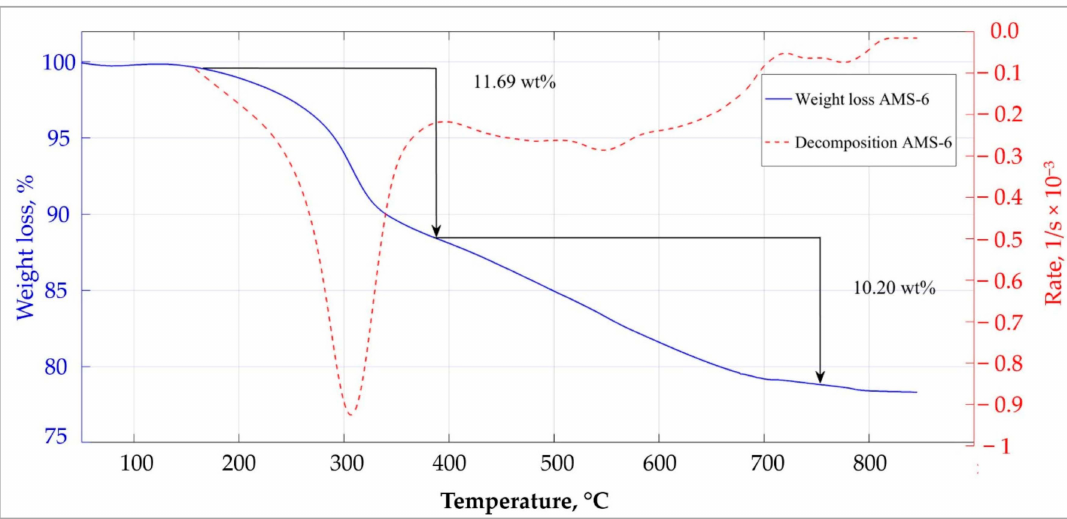
Figure A19. Thermogravimetric analysis of the unloaded AMS-6 nanoparticles sample. The thick blue line corresponds to the weight loss versus the temperature, and the dashed red line represents the first derivative from the thermogravimetric analysis (DTG) curve. The latter shows characteristic decomposition peaks, e.g., at 380 ◦ C. The measurement was performed on the pure AMS-6 to confirm the absence of any organic compounds that could block the pores, which were supposed to contain the loaded drug later. The peak of DTG at approximately 310 ◦ C corresponds to the loss (decomposition) of propyl amine functionalized groups. The analysis also revealed the incorporation of approximately 11.69 wt% of covalently bound propyl amine groups in the pores of the NPs. However, with 11.69 wt%, the presence of amine groups was slightly elevated. A higher value would indicate a high amount of remaining amino groups, which would mean a blockage of the NPs pores. The remaining weight loss above 400 ◦ C was due to evaporating water (also known as extra framework water) caused by condensation of silanol